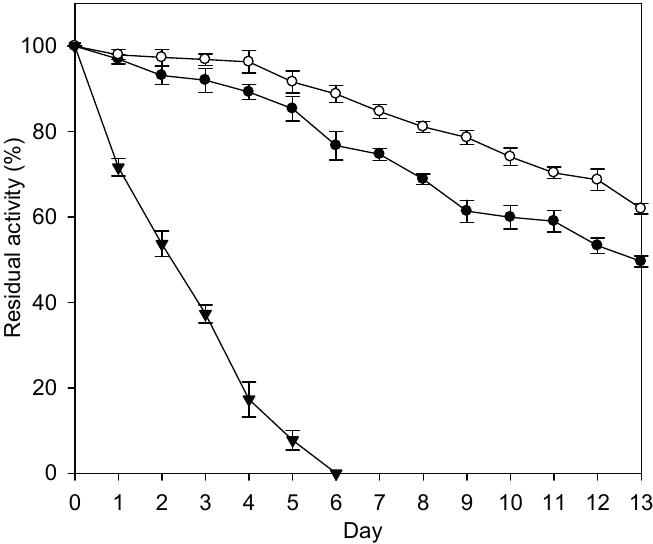
Figure 5. Long-term thermal stability of the enzymes at 45 °C. The data are averaged from three samples. ( ● ) Fe 3 O 4 -CS-immobilized enzyme; ( ○ ) Fe 3 O 4 -CS-THP-immobilized enzyme; ( ▼ ) free